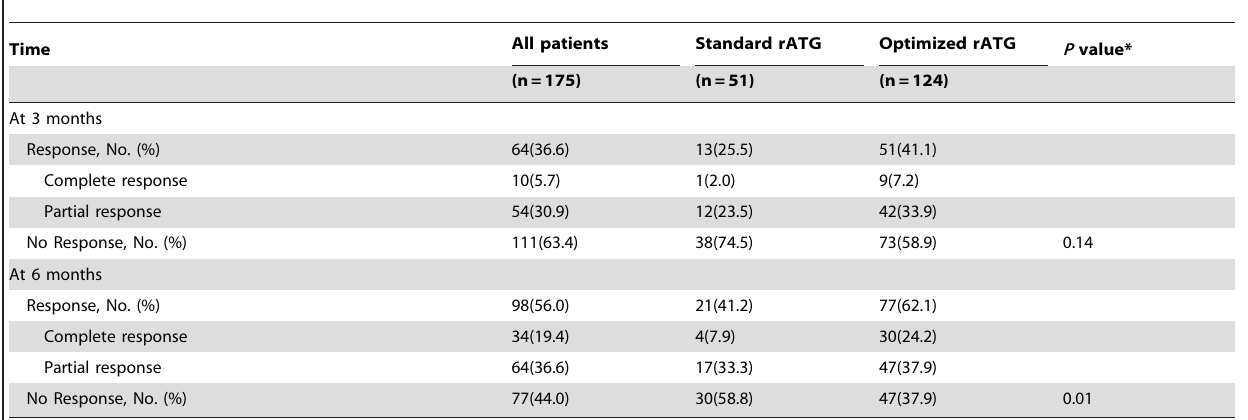
Table 2. Hematological response to Standard and Optimized rATG